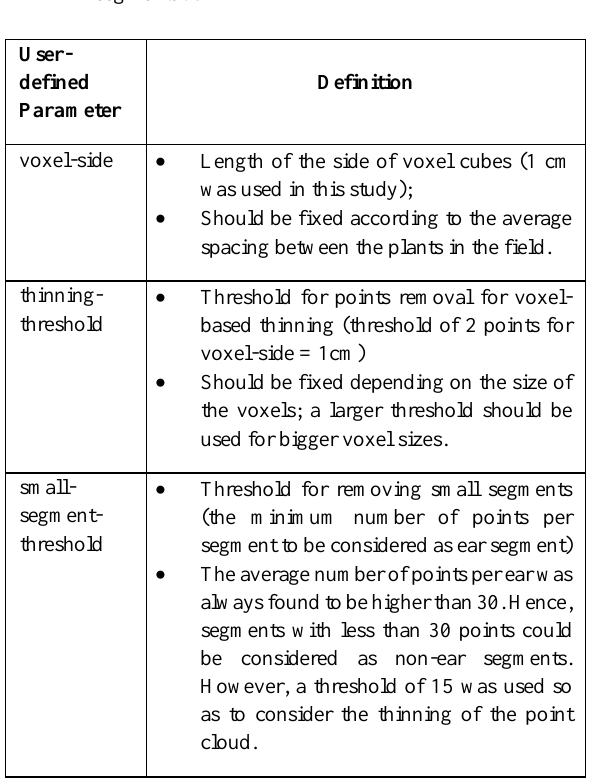
Table 1 User-defined parameters used in voxel-based